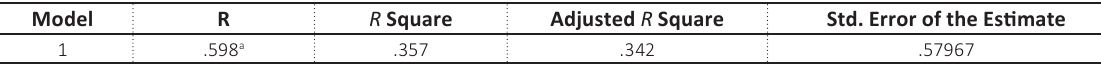
Table 5.1. Value of R square